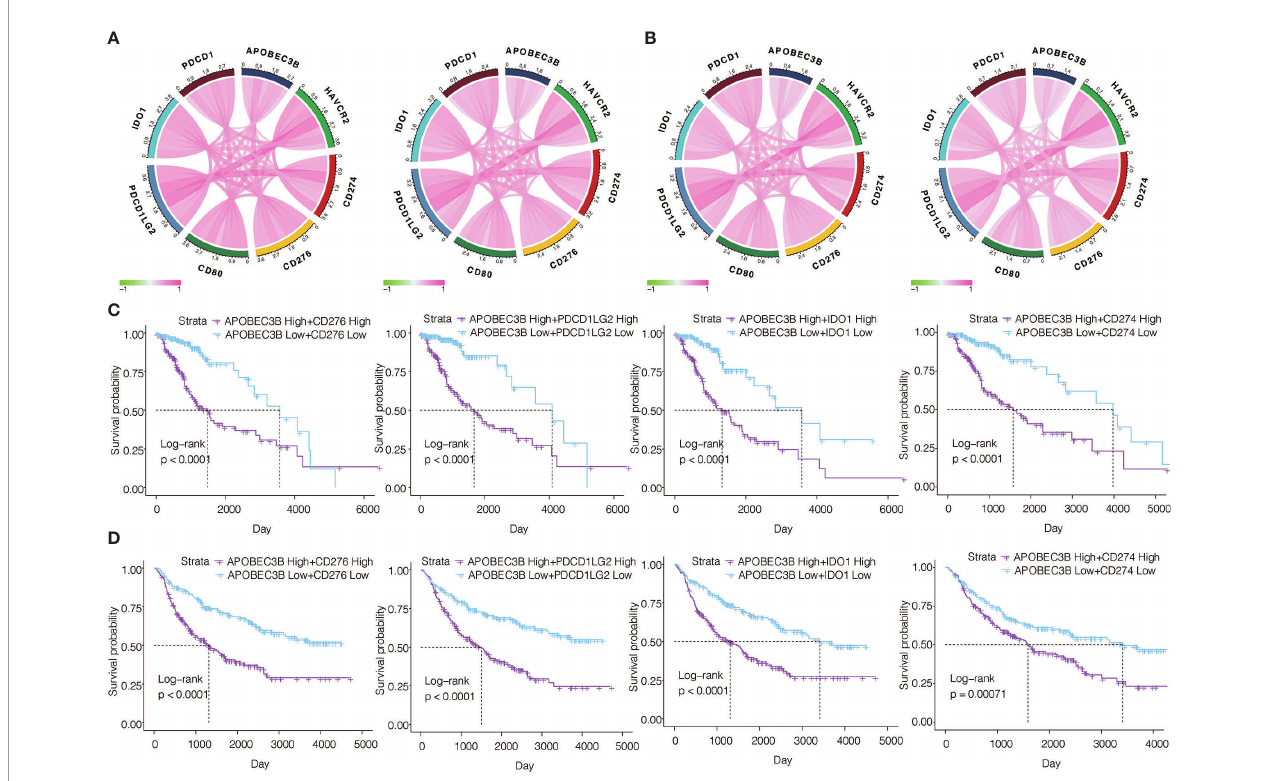
FIGURE 8 | Correlation of APOBEC3B expression with other immune checkpoint molecules in gliomas. Correlation analyses of APOBEC3B and other immune checkpoints in (A) pan-glioma analysis and (B) LGG patients from TCGA (left) and CGGA (right) datasets. Analyzing combined prognostic value of APOBEC3B and CD276, PDCD1LG2, IDO1 and CD274 expression in LGG patients from (C) TCGA and (D) CGGA